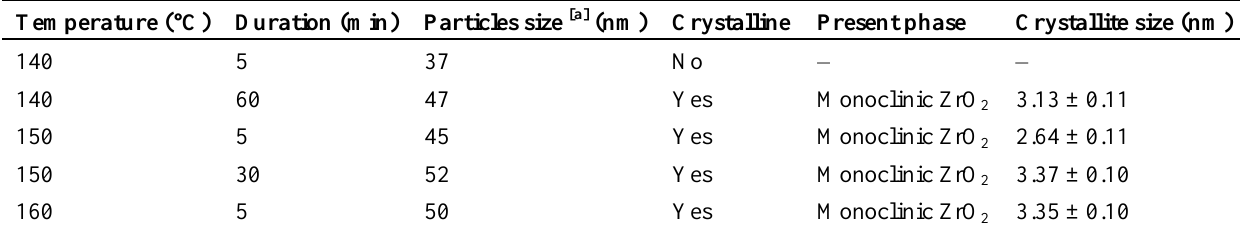
Table 1. Overview of microwave treated solution A where the temperature and duration of the synthesis are represented in function of the particle size and